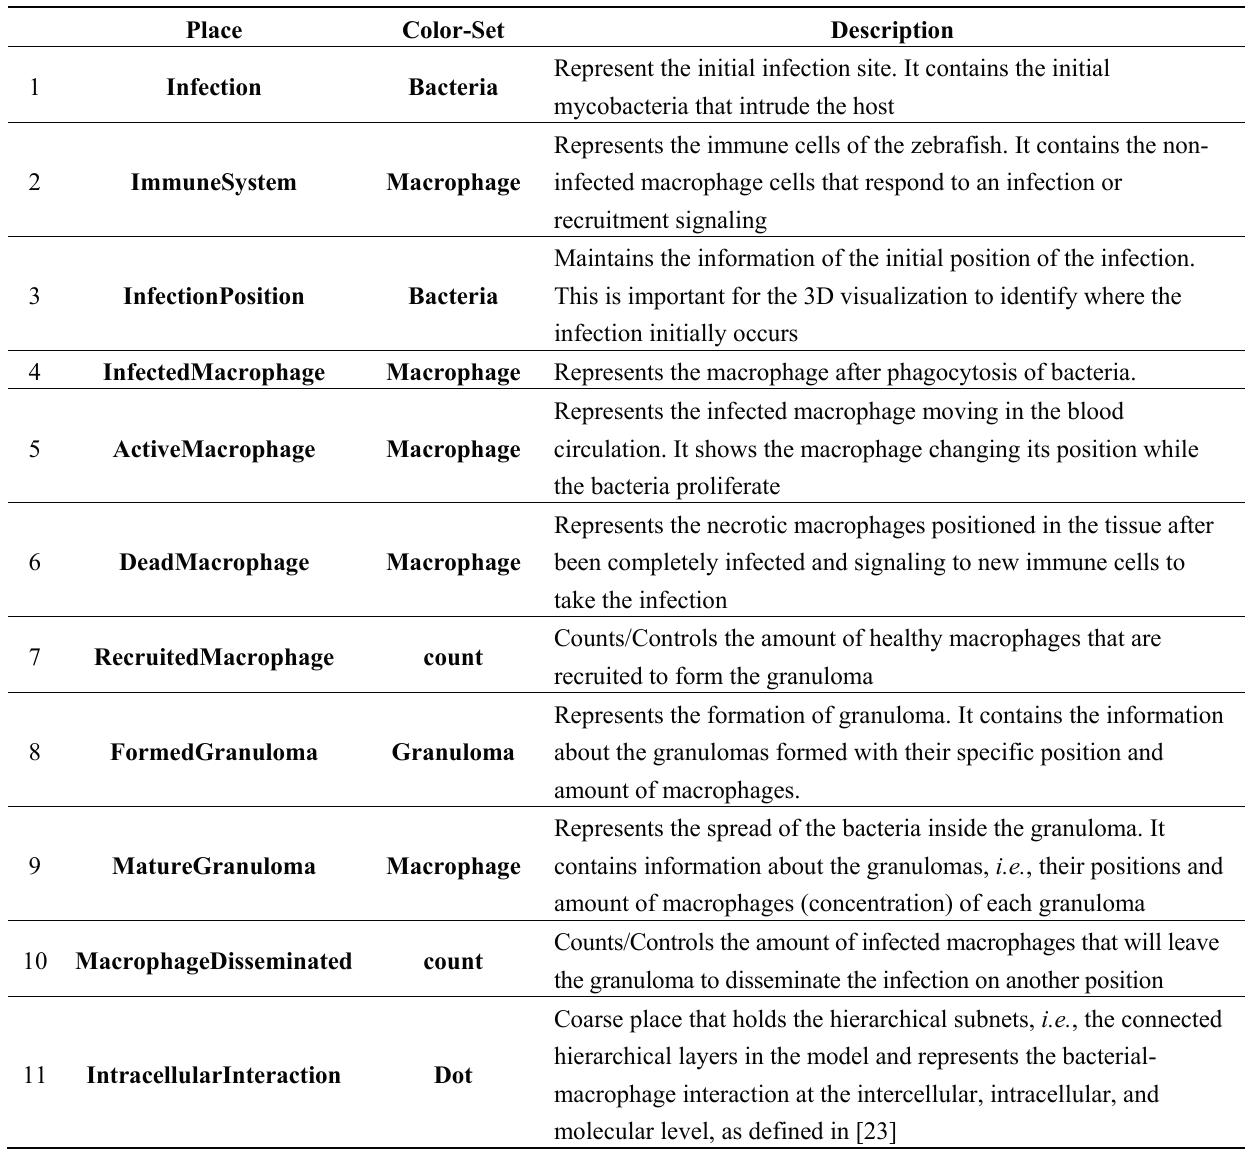
Table 3. Set of places composing level 1 of the